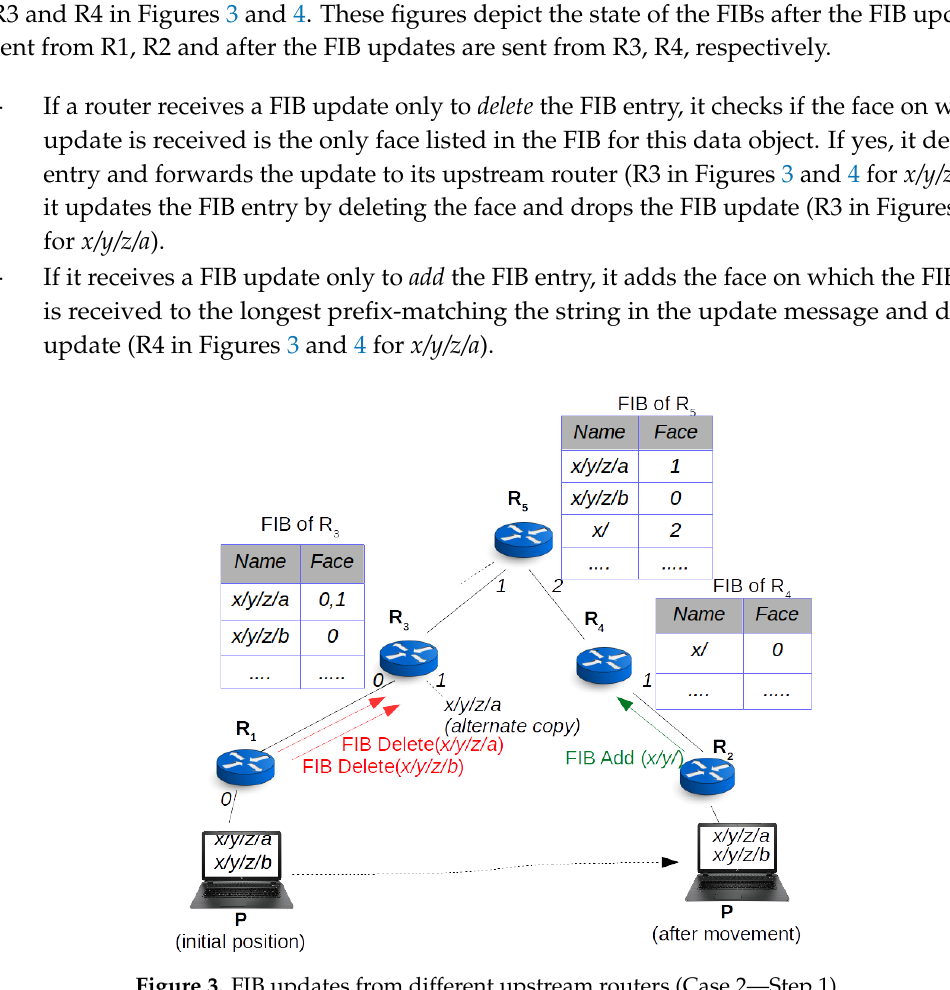
Figure 3. FIB updates from different upstream routers (Case 2—Step 1).